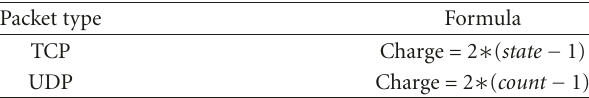
Table 1: Formulas for packet